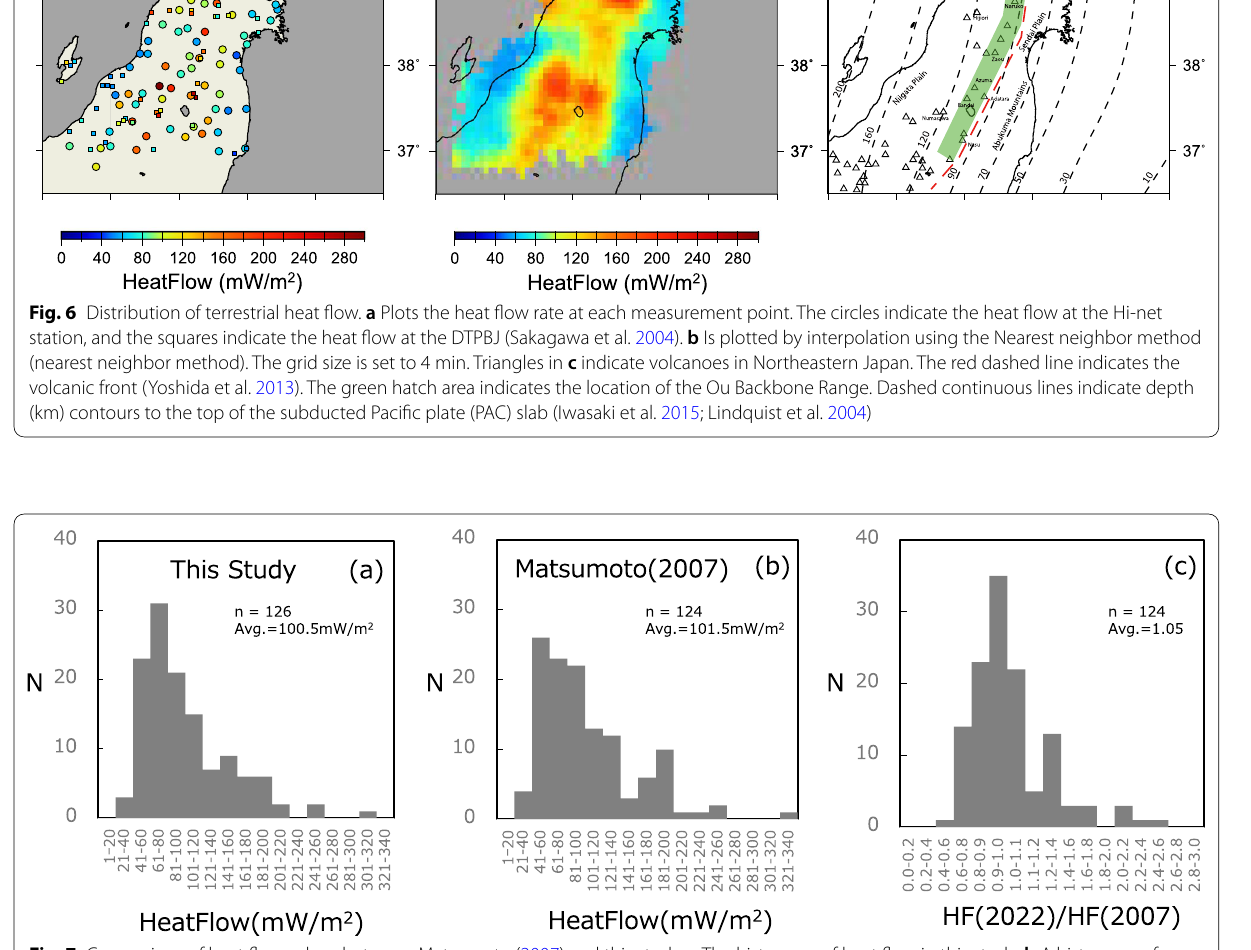
Fig. 7 Comparison of heat flow values between Matsumoto (2007) and this study. a The histogram of heat flow in this study. b A histogram of the heat flow in Matsumoto (2007). c The ratio of the heat flow estimated in Matsumoto (2007) to the heat flow estimated in this study for each